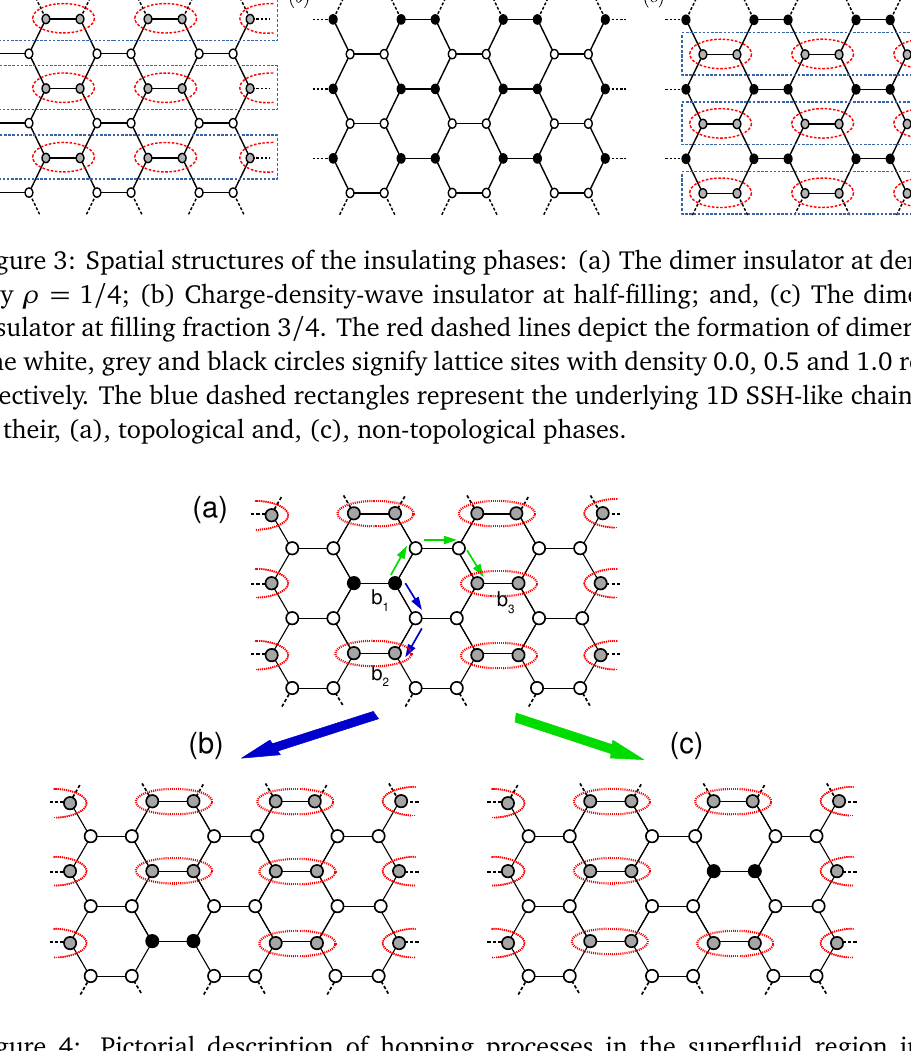
Figure 4: Pictorial description of hopping processes in the superfluid region in- between the dimer insulator at ρ = 1 / 4 and CDW structure at ρ = 1 /